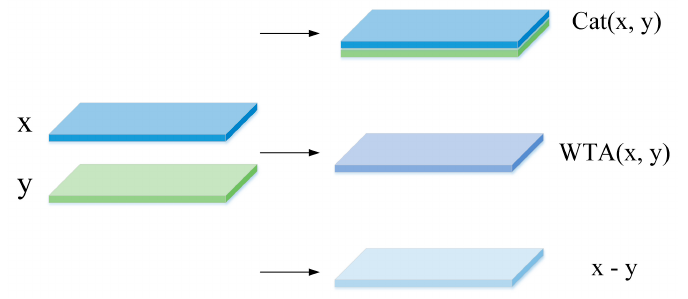
Figure 5. Three single ways to build cost volume. x and y features are used for channel connections, winner-take-all, and difference fusion.